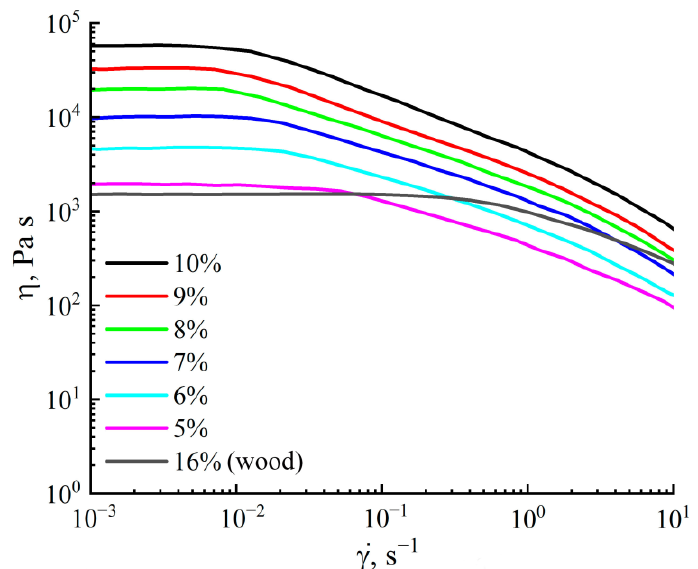
Figure 7. Flow curves of flax noils and wood cellulose solutions with different polymer concentra- tion, T = 120 °C. T = 120 ◦